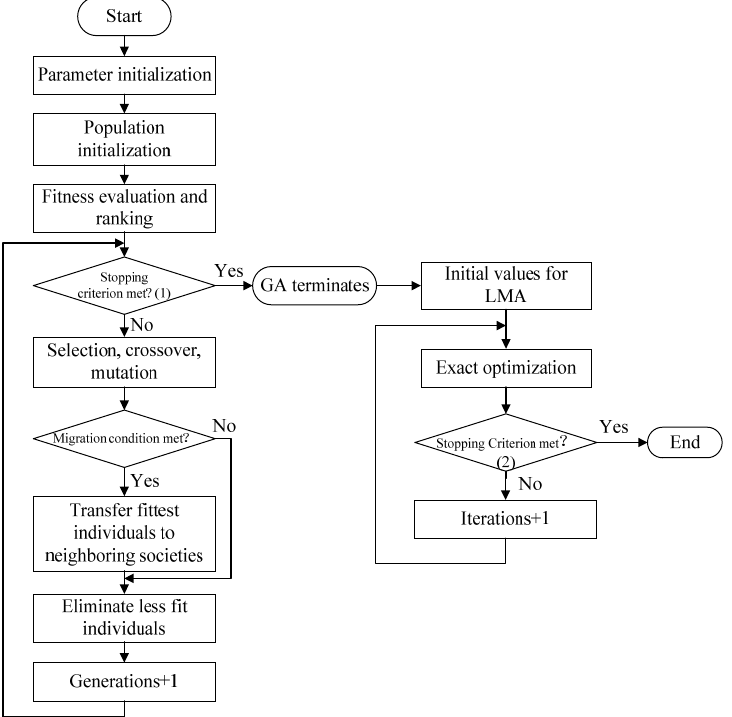
Figure 2. The flow chart of the combination of the genetic algorithm (GA) and the Levenberg–Marquardt Algorithm